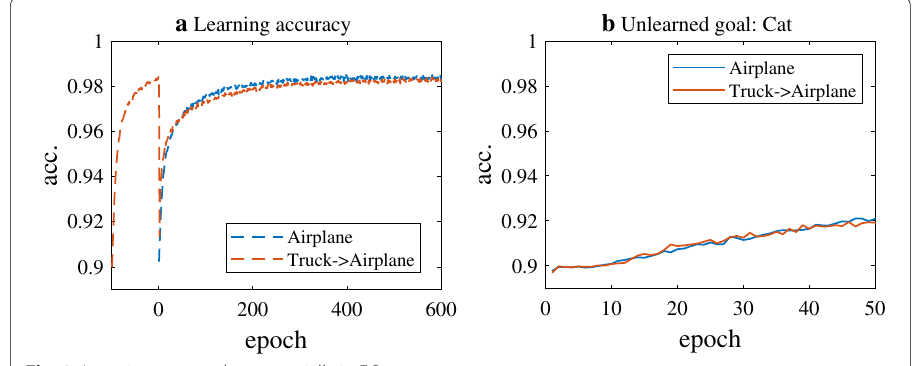
Fig. 8 Learning two goals sequentially in FG manner